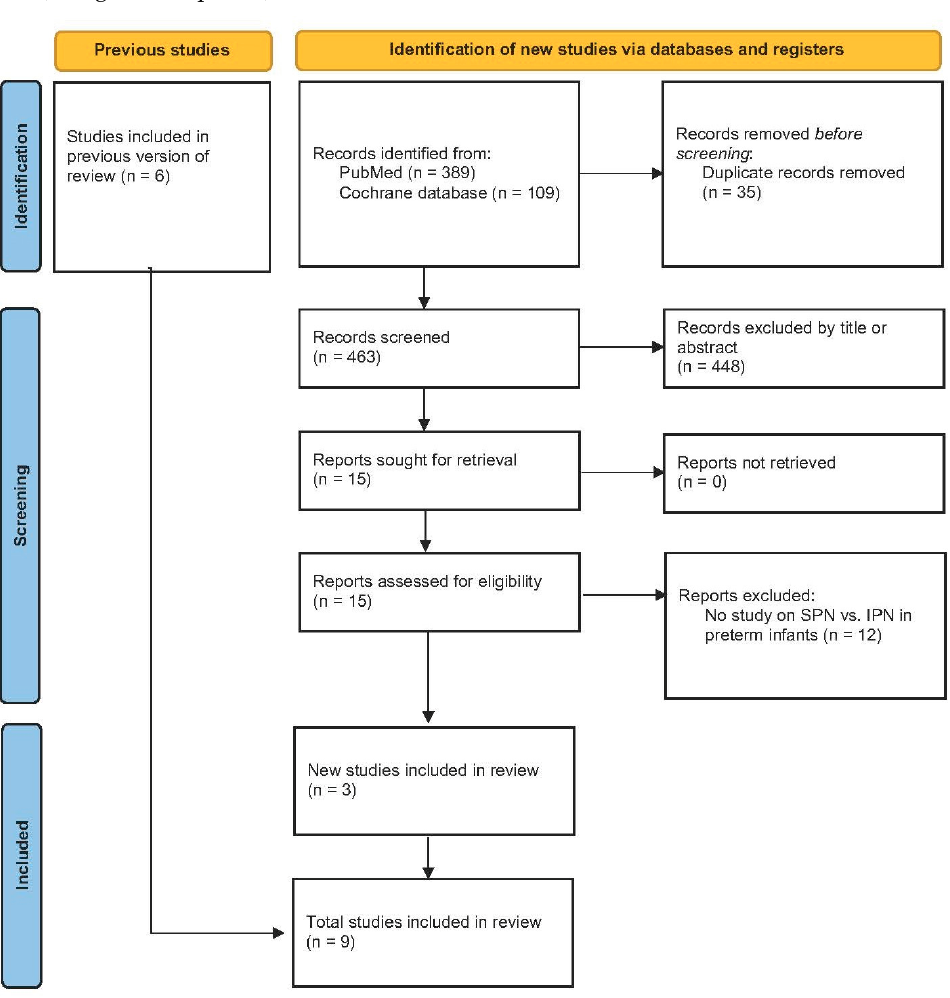
Figure 1. PRISMA flow diagram. (Standardized parenteral nutrition (SPN), individualized parenteral nutrition (IPN)).